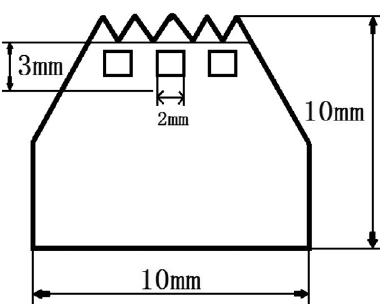
Fig. 3: Schematic diagram showing sampling plan of carbon